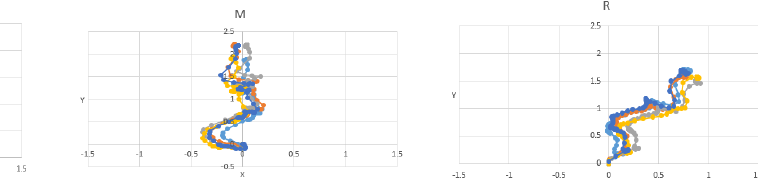
Figure 9. Learning to move to the left, forward, and to the right.